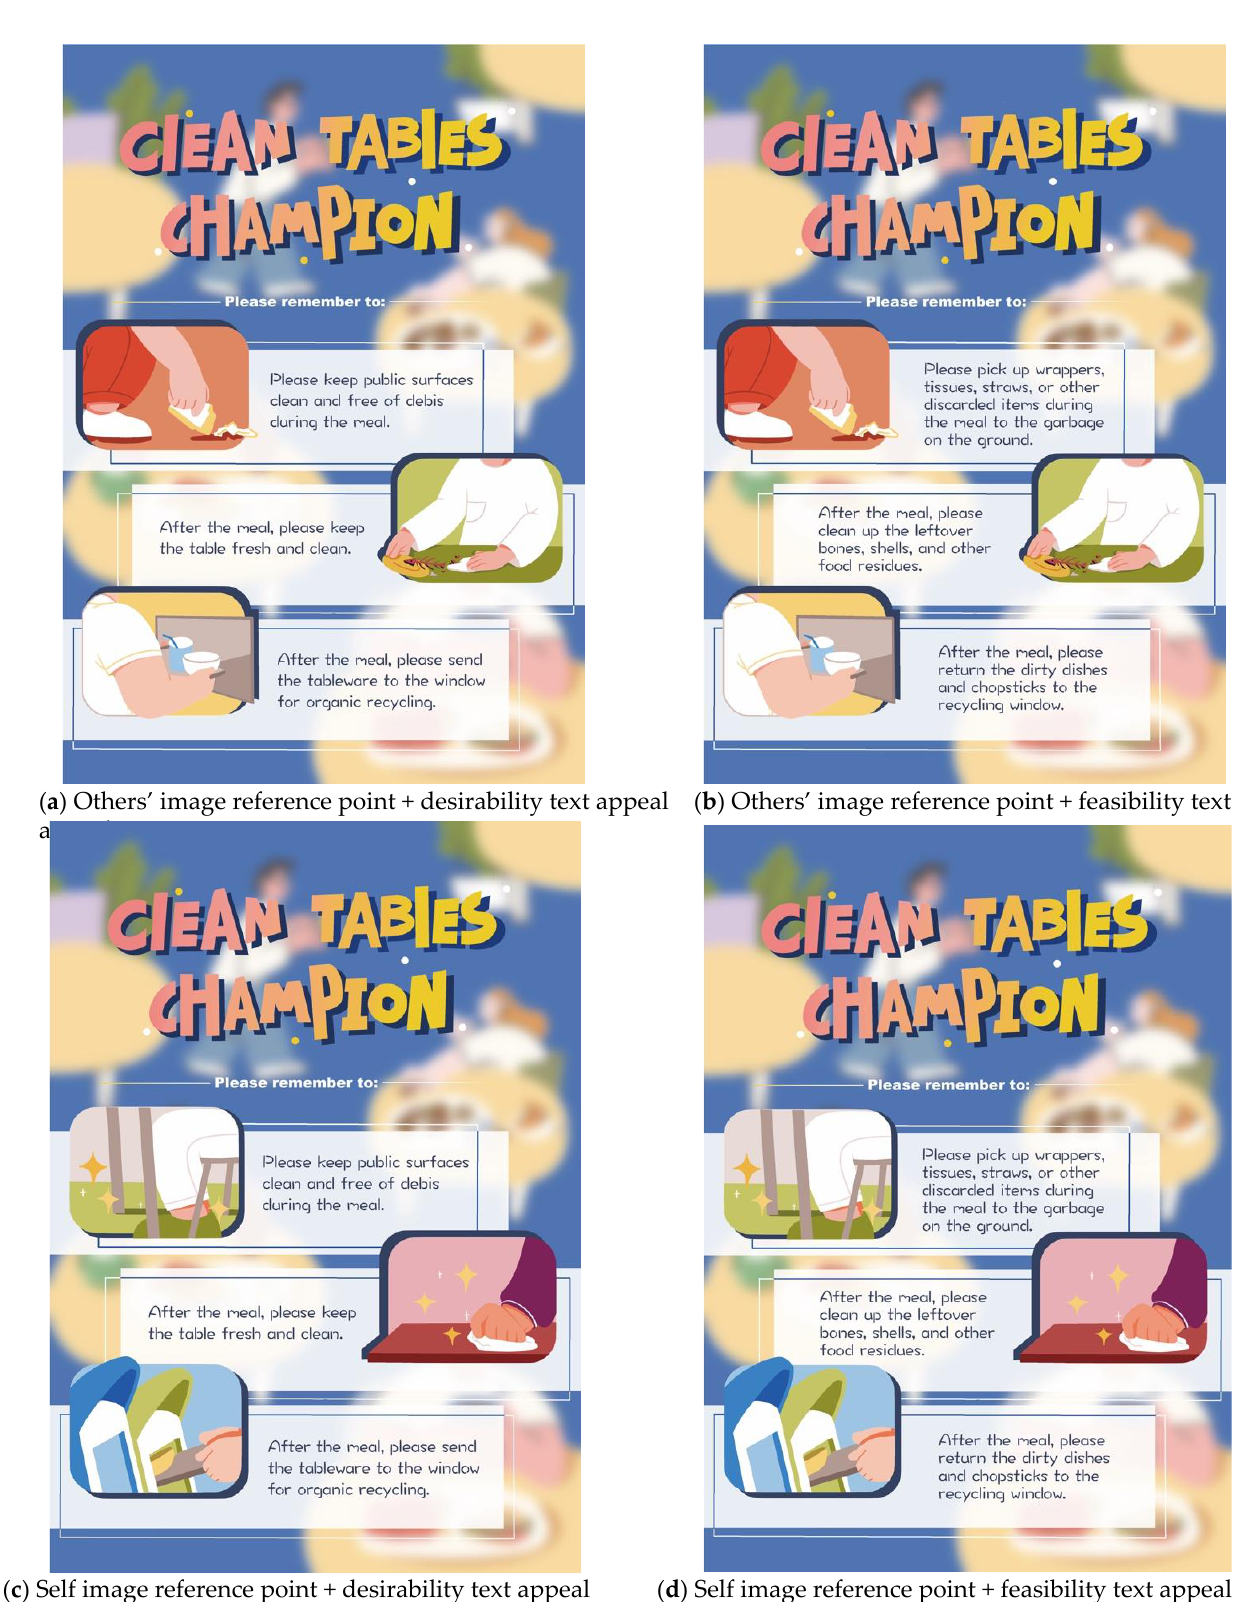
Figure 1. Stimulus materials design. (Note: The original four groups of presentation materials are in Chinese, and we translated them into English for this paper).